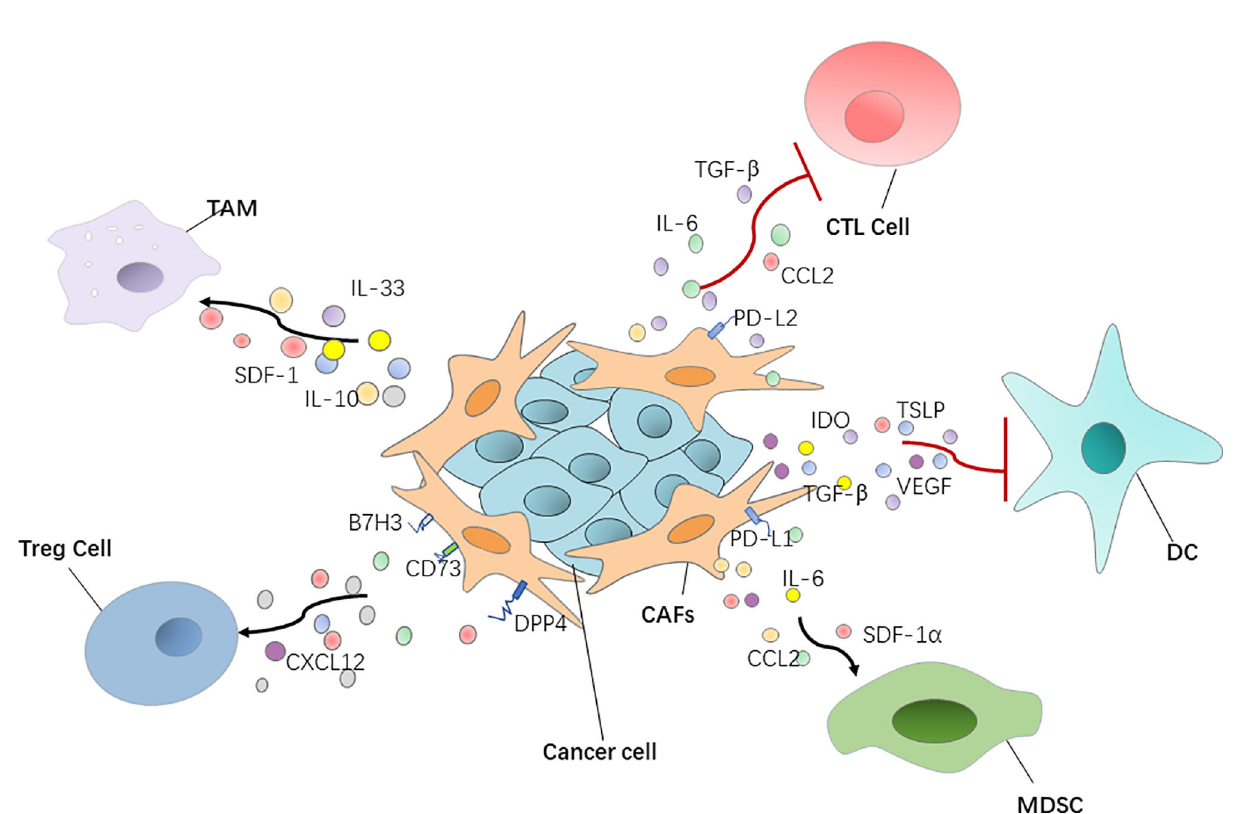
FIGURE 1 | CAFs have a positive or negative interaction with immune cells via regulating various cytokines and chemokines. DC, dendritic cell; Treg cell, regulatory T cell; MDSC, myeloid ‐ derived suppressor cell; TGF ‐ b , transforming growth factor ‐ b ; SDF-1, stromal-derived growth